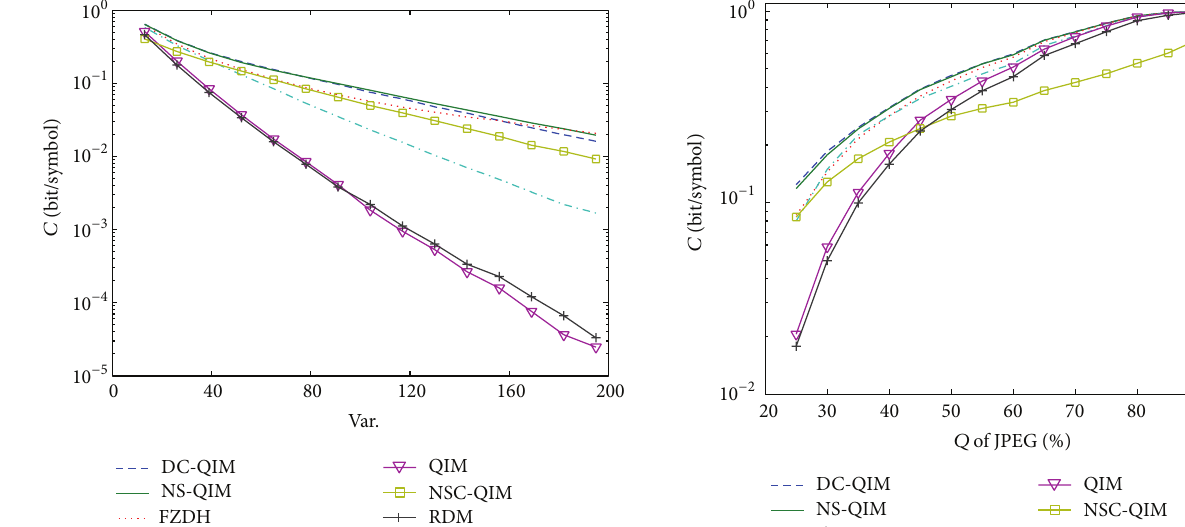
by squares, triangles, and crosses, respectively, in Figure 4.